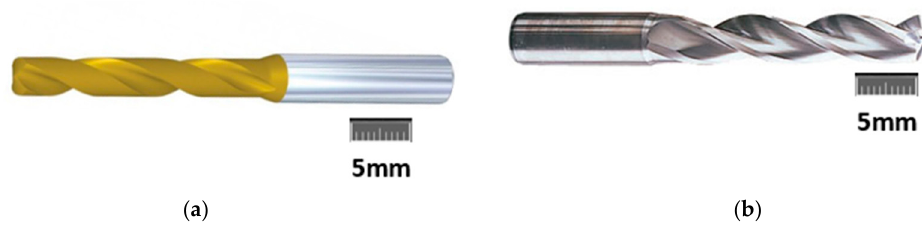
Figure 1. Carbide twist drills: ( a ) TiAlN multilayer fine-grain grade KC7325; ( b ) uncoated carbide— K10.